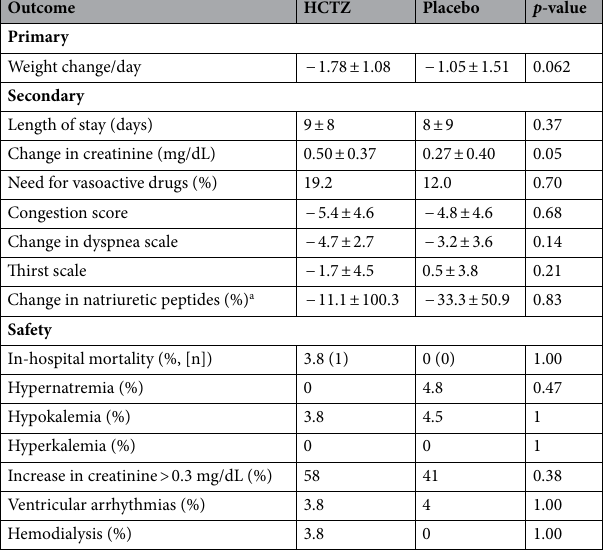
Table 3. Study outcomes. Plus–minus values are means ± standard deviation. a Natriuretic peptides were